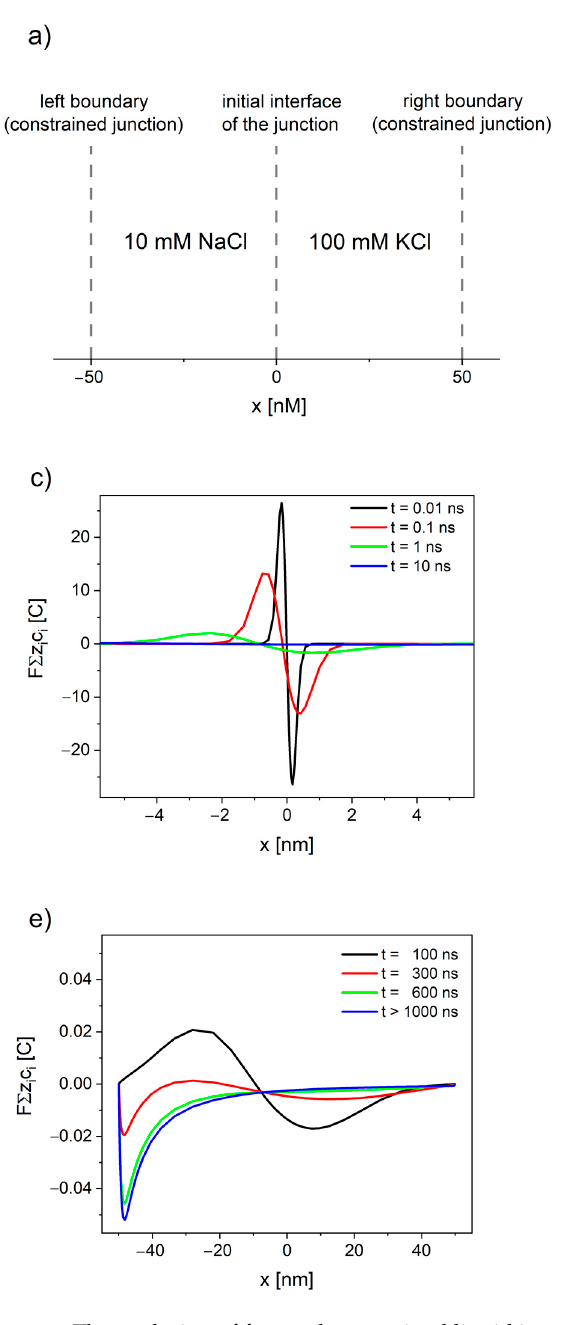
Figure 1. The evolution of free and constrained liquid junction potential (LJP) of watery solutions 10 mM NaCl|100 mM KCl calculated using Nernst–Planck–Poisson (NPP) model: ( a ) schematic depiction of the liquid junction system; ( b ) the liquid junction potential as a function of time; ( c , e ) deviation from electroneutrality; and ( d , f ) the resulting electric field.